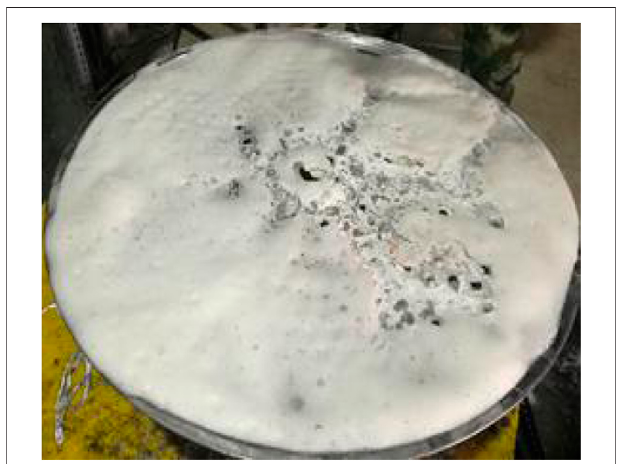
FIGURE 12 | Composite foam extinguishing agent in CO concentration determination